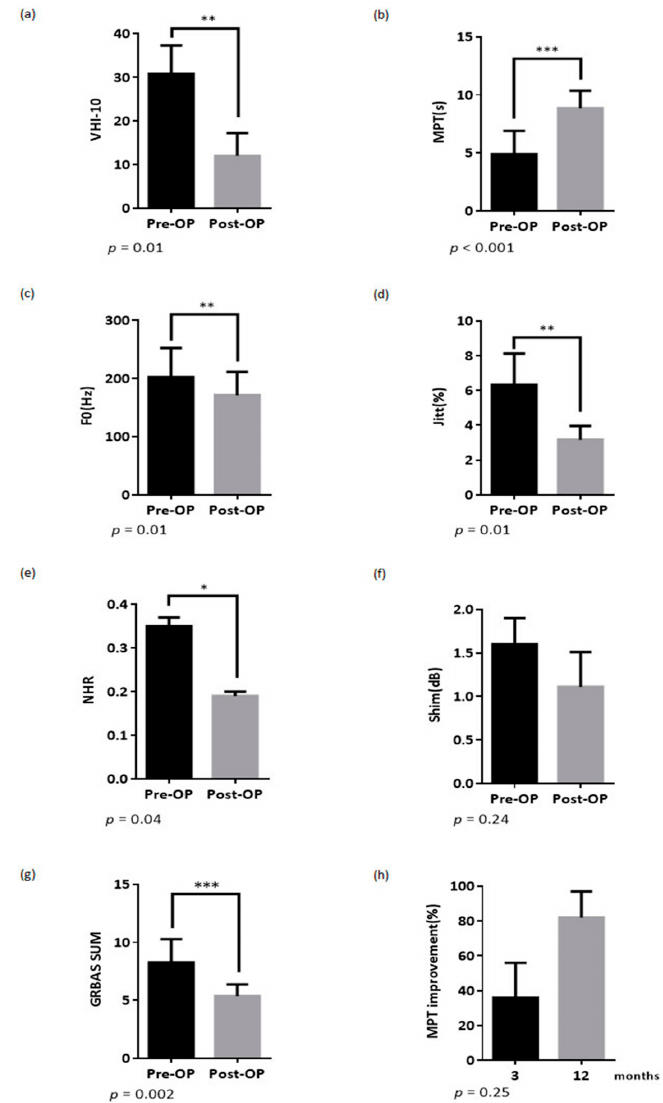
Figure 1. The pre-operative and post-operative acoustic analysis result of study patients ( a ) Pre- and postoperative Voice Handicap Index (VHI)-10 scores, ( b ) Pre- and postoperative maximum phonation times (MPT)s, ( c ) Pre- and postoperative F0, ( d ) Pre- and postoperative Jitt, ( e ) Pre- and postoperative noise-to-harmonic ratio (NHR), ( f ) Pre- and postoperative shimmer, ( g ) Pre- and postoperative GRBAS-sum (G = grade, R = roughness, B = breathiness, A = asthenia, and S = strain), ( h ) MPT improvement at 3 and 12 months. The * p < 0.05, ** p < 0.01 and *** p < 0.001 indicate the statistical significance of di ff erences between pre-operation and